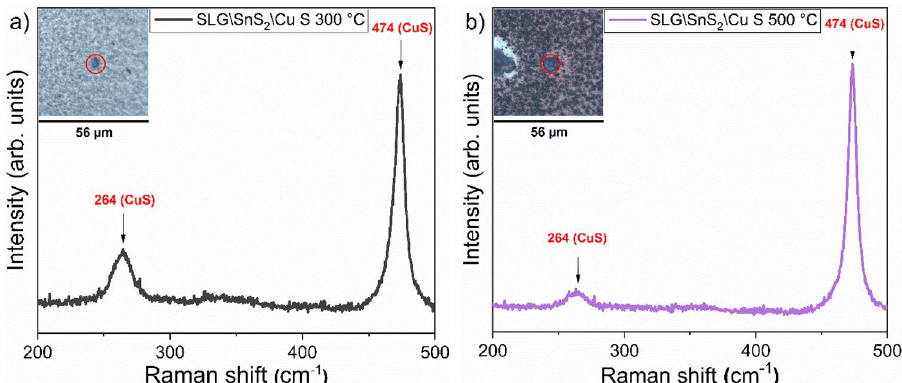
Figure 6. Raman spectra of the CTS samples measured using a 325 nm excitation wavelength on large grains to identify the CuS secondary phase. ( a ) SLG\SnS 2 \Cu 300 °C and ( b ) SLG\SnS 2 \Cu 500 °C in S atmosphere. The inset represents the microscopic image of the measured